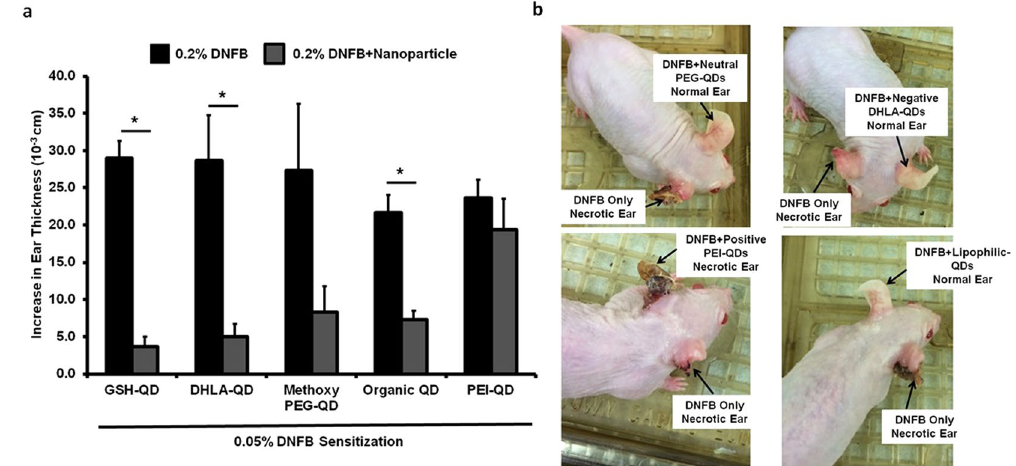
Figure 4. Co-challenge experiments with Methoxy PEG-QD, DHLA-QD, organic (lipophilic) QDs and PEI-QD. ( a ) Mice were sensitized to 0.05% DNFB. In the challenge phase, the right ear was exposed to 0.2% DNFB alone and the left ear was co-challenged with 0.2% DNFB + QD combinations. GSH-QD (negative charge), DHLA-QD (negative charge), Methoxy PEG-QD (neutral charge) and organic QD all inhibited the ear swelling response (p = 0.01, p = 0.02, p = 0.07 and p = 0.005 respectively). PEI-QD with a positive charge did not inhibit the ear swelling response (p = 0.42). Mean ± SEM, * p < 0.05, 2 tailed t-Test, paired with unequal variances, N = 3. ( b ) These mice were followed for a month after the challenge phase. The right ear treated with 0.2% DNFB forms scabs 72 hours after challenge and the ear necrotic after 4 weeks. The groups in which the QD inhibited the ear swelling response, the left ear is intact after a month. PEI-QD did not inhibit the swelling response so the left ear is necrotic as shown in the gross image.